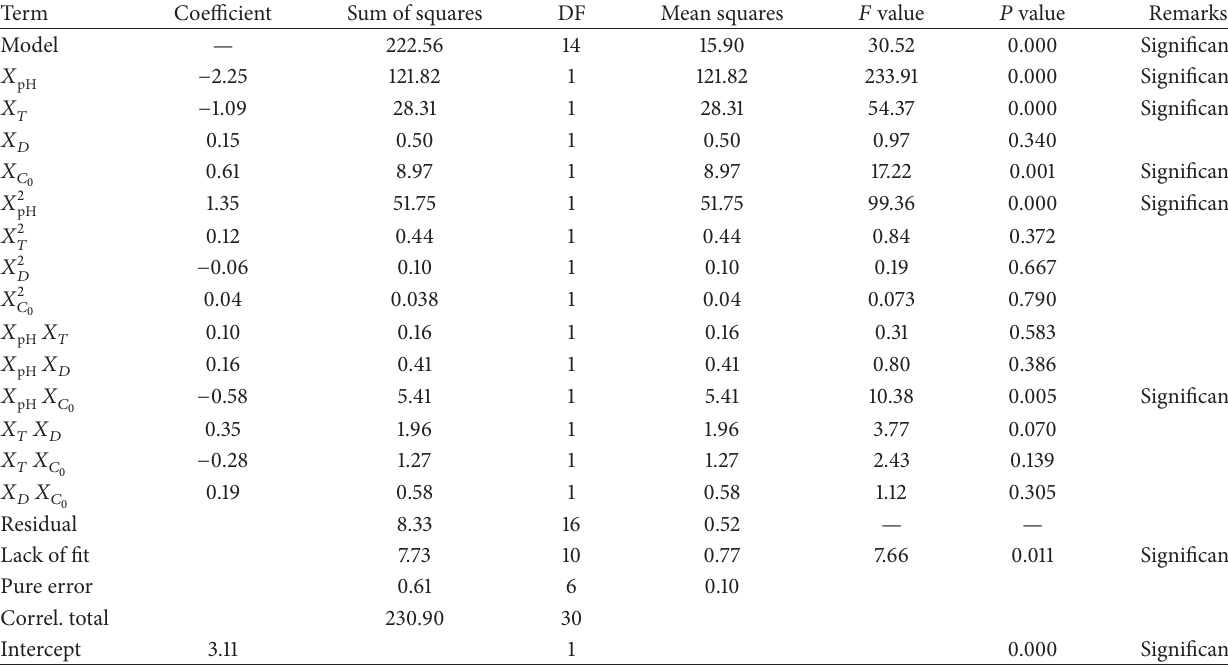
Table 5: Analysis of variance (ANOVA) for response surface quadratic model for adsorption of AB1.